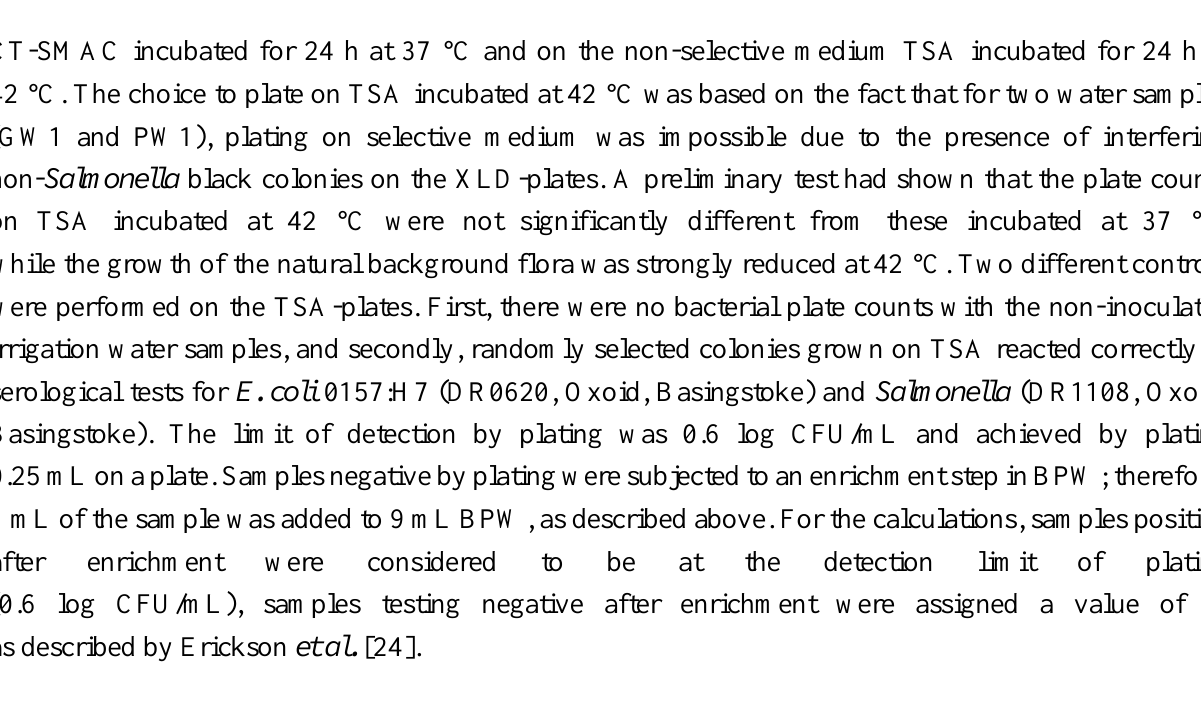
Table 1. Overview of the 4 pathogen strains and 14 variables tested to measure pathogen survival and background bacteria in each irrigation water